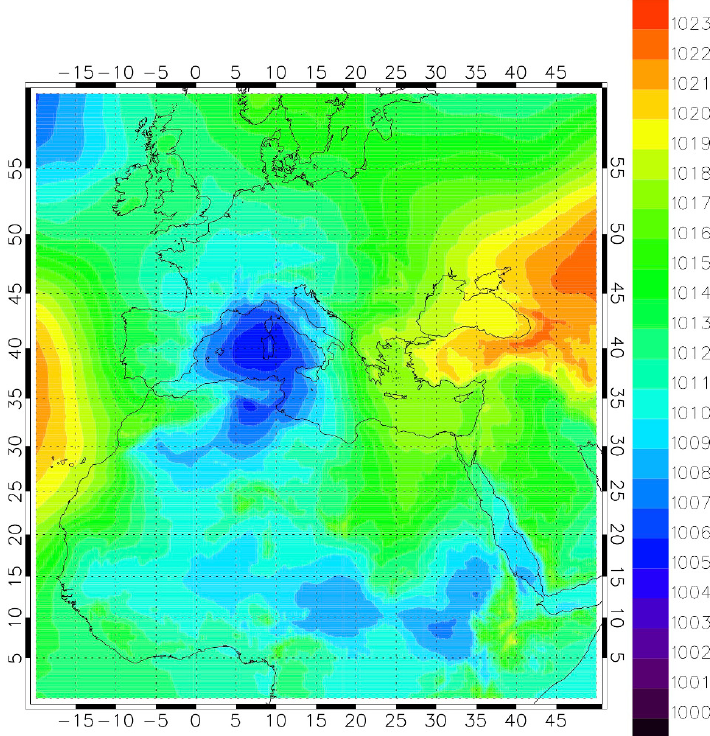
Figure 3. Averaged (at 00 UTC for the selected 15 “dust events”) mean sea level pressure (hPa). The maps are generated using Copernicus Climate-Change Service Information